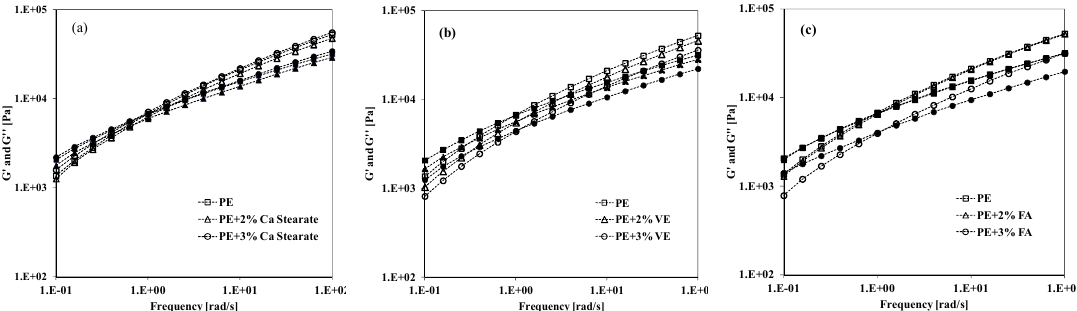
Figure 2. Storage (G ′ ) and Loss (G ′′ ) moduli of neat PE and PE containing different compounds as a function of the frequency. ( a ) Ca stearate; ( b ) Vitamin E; ( c ) Ferulic Acid.